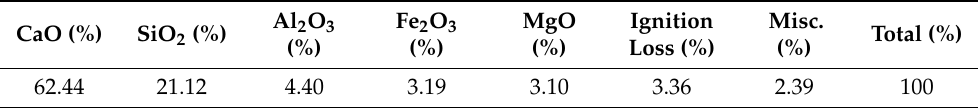
Table 4. Chemical composition of cement.